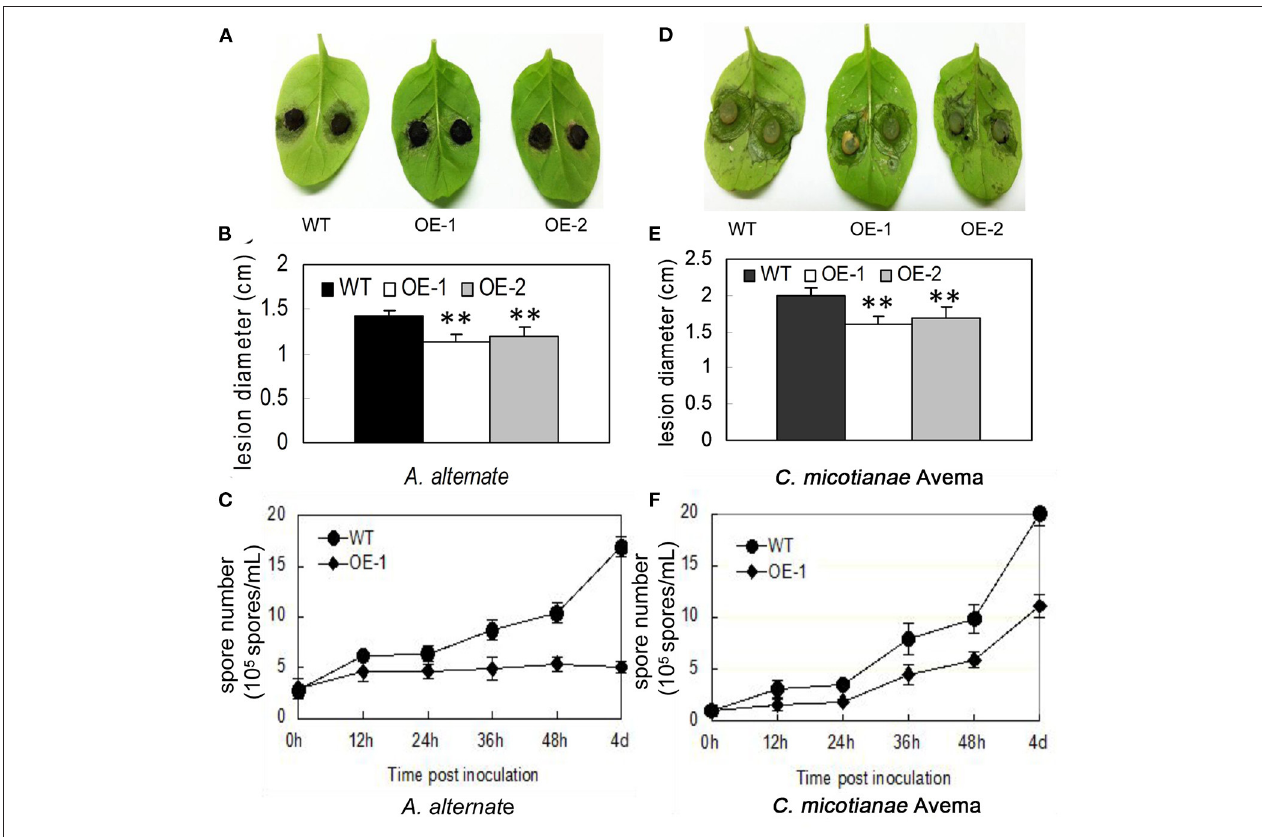
FIGURE 3 | Characterization of resistance to A. alternata and C. nicotianae Averna for AtMYB12-expressing transgenic tobacco. (A) Performance of the wild-type (WT) and two lines of AtMYB12 overexpression tobacco (OE-1, OE-2) after inoculation with A. alternata for 7 days. (B) Lesion diameter from A. alternata after inoculation in tobacco leaves. The values represent the average of three technical replicates. (C) Growth curve of the A. alternata isolate after the inoculation of 3 × 10 6 spores · ml − 1 in tobacco leaves. The spore numbers were counted 0, 12, 24, 36, 48h, and 4 days after infiltration. The values are the means ± SD ( n = 5). (D) Performance of the wild-type (WT) and two lines of AtMYB12 overexpression tobacco (OE-1, OE-2) after inoculation with C. nicotianae Averna for 7 days. (E) Lesion diameter of C. nicotianae Averna after inoculation in tobacco leaves. The values represent the average of three technical replicates. The values are the means ± SD ( n = 3, * p < 0.05, ** p < 0.01). (F) Growth curve of the C. nicotianae Averna isolate after the inoculation of 10 6 spores · ml − 1 in tobacco leaves. Spore numbers were counted 0, 12, 24, 36, 48h, and 4 days after infiltration. The values are the means ± SD ( n =